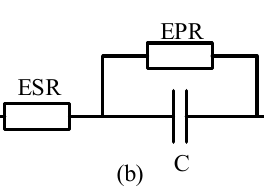
Figure 6. Transmission line model. 4.1.3. Multi-Branch RC Network Models The form of the multi-branch RC model is similar to that of the transmission line model. What is different from the transmission line model is that each branch of the model has a different time constant, and each branch acts independently in different time periods of the charging and discharging process. A ladder circuit composed of multiple RC